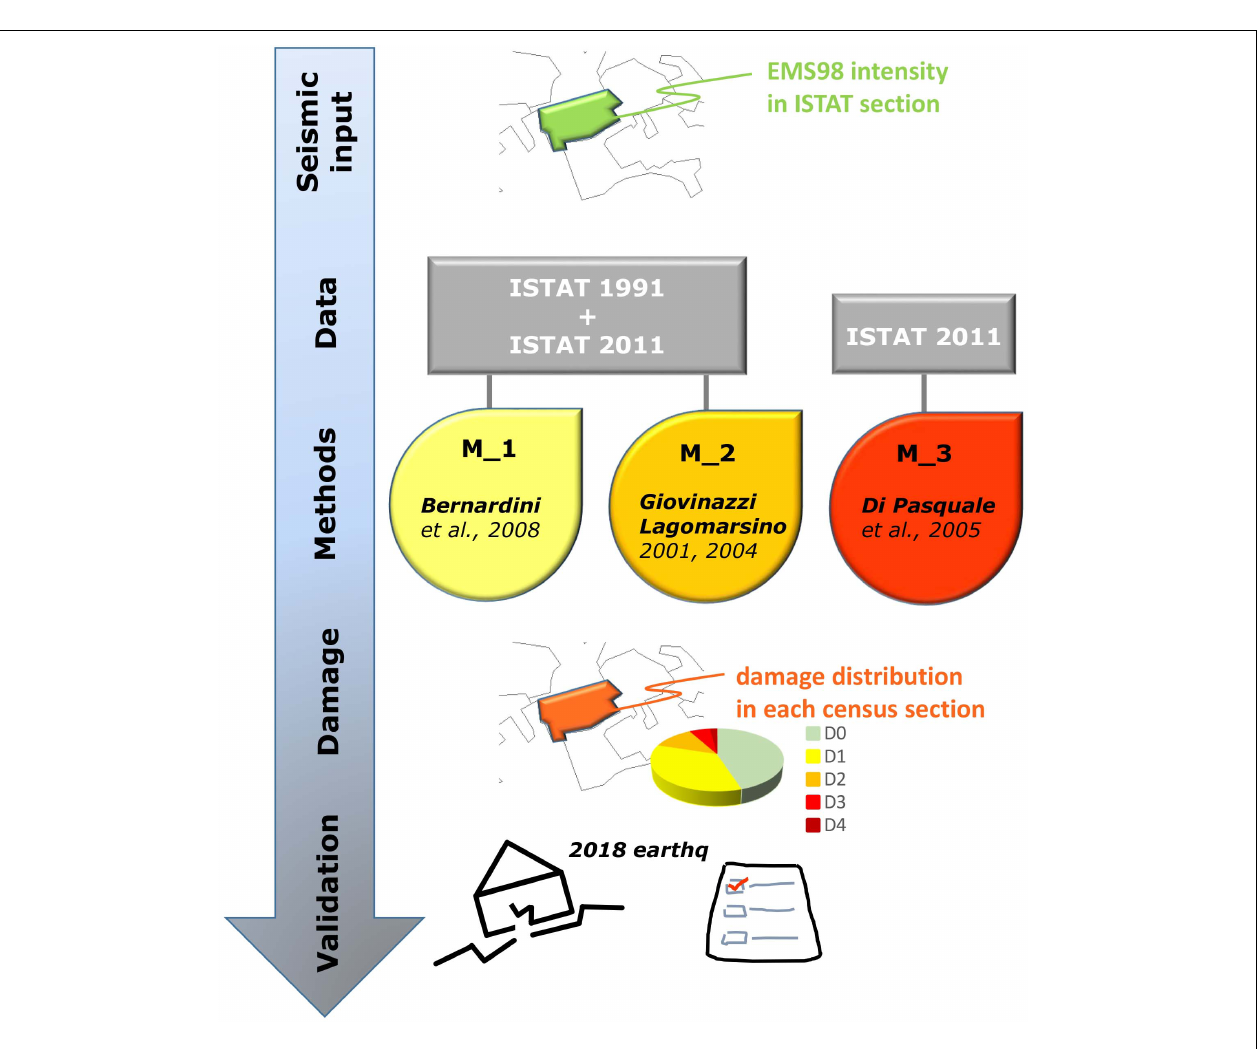
Frontiers in Earth Science |